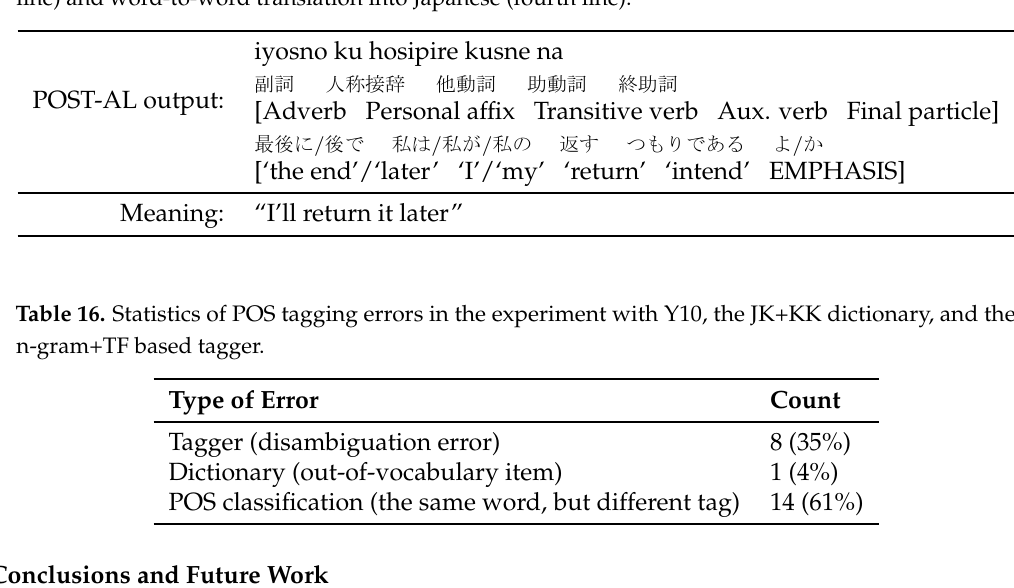
Table 15. A sentence from the JK dictionary processed by POST-AL, with POS annotations (second line) and word-to-word translation into Japanese (fourth line).